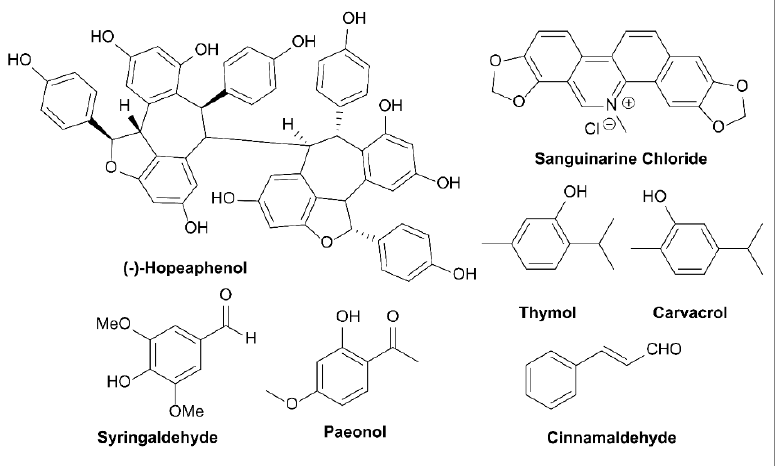
Figure 12. Structures of Hopeaphenol, Sanguinarine Chloride, Thymol, Carvacrol, paeonol, and Cinnamaldehyde.